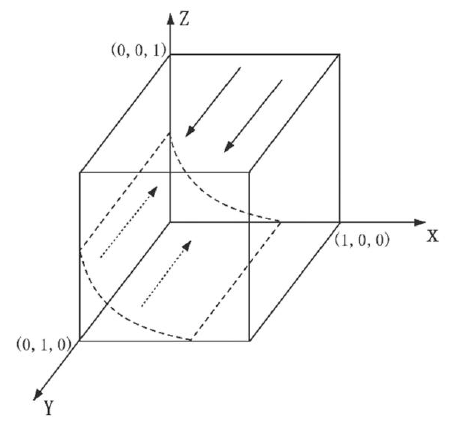
Figure 3. Evolution phase diagram of local government strategy selection.